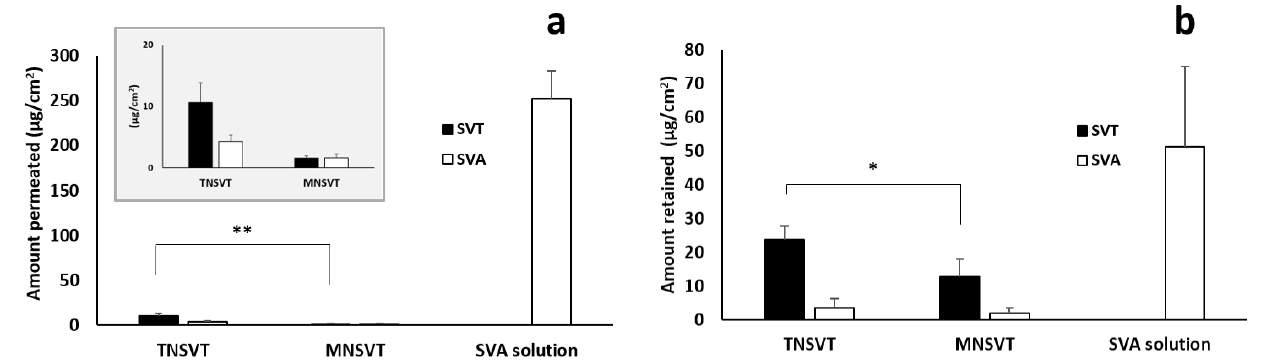
Figure 3. SVT (black) and SVA (white) permeated across (panel a ) and retained (panel b ) within porcine sclera after 48 h application of TN SVT , MN SVT or SVA solution. In panel ( a ), an insert depicting the magnification of TN SVT and MN SVT is shown (statistically difference: * p < 0.05, ** p < 0.01).